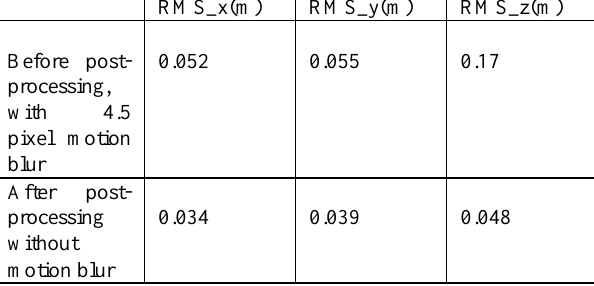
Table 1. AT residuals of the check points Table.1 shows that the RMS of the horizontal points after motion compensation, when considering a 2 pixel error for measuring non-signalized control points, is improved and in an acceptable range. This improvement is more obvious in vertical points and shows that the linear blur compensation in absence of the angular motion blur, has a greater effect on the vertical accuracy. It is expected to achieve better absolute accuracies within 1 pixel for horizontal and 2 pixels for height by using signalized control points.